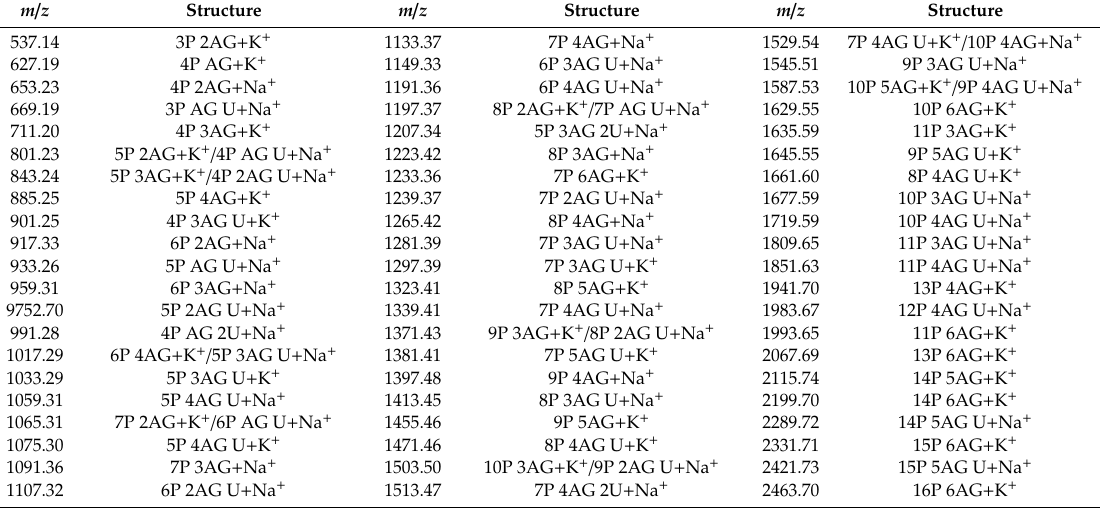
Table 4. OS structures in the retentate stream identified by MALDI–TOF